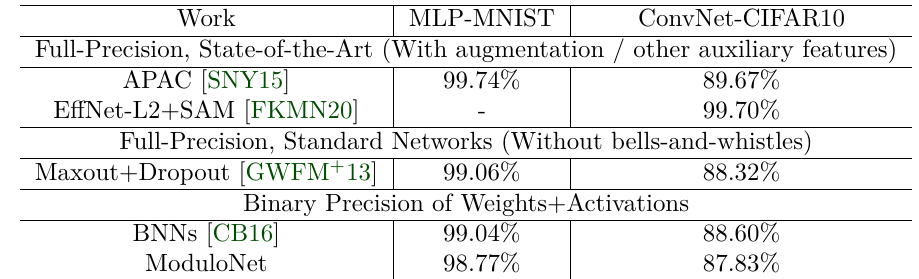
Table 1: Accuracy Comparison of ModuloNET against BNNs, Full-precision and state-of- the-art